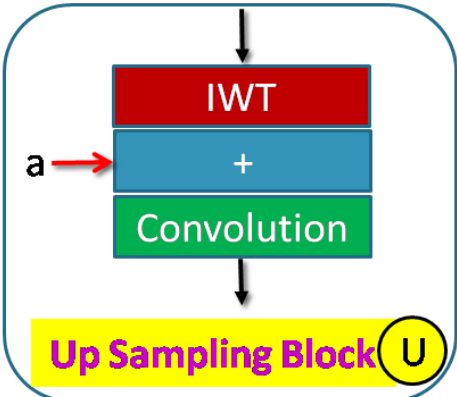
Figure 6. The up–sampling block provides IWT and convolution operations. Information from the skip path ‘a’ is also